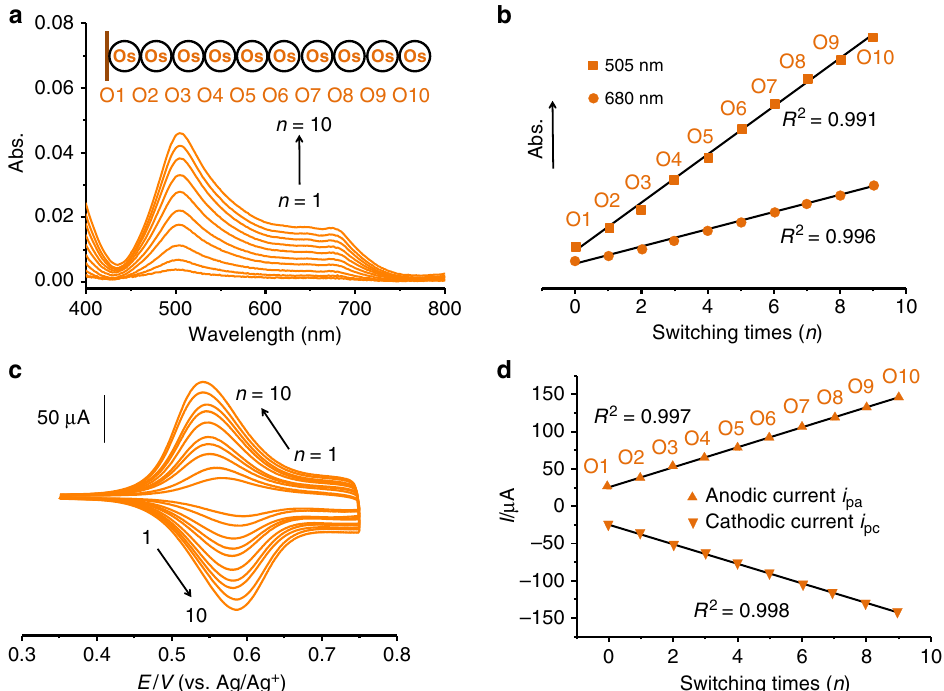
Fig. 2 Electrosynthesis of homo-organometallic polymers. a , b Illustrations of UV – vis absorbance and intensities as a function of switching times during iterative synthesis. c , d Illustrations of CV and its intensities of redox peaks as a function of switching times during iterative